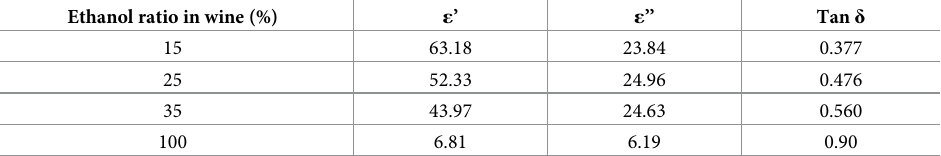
Table 1. Dielectric parameters and loss tangent value for the wine-ethanol